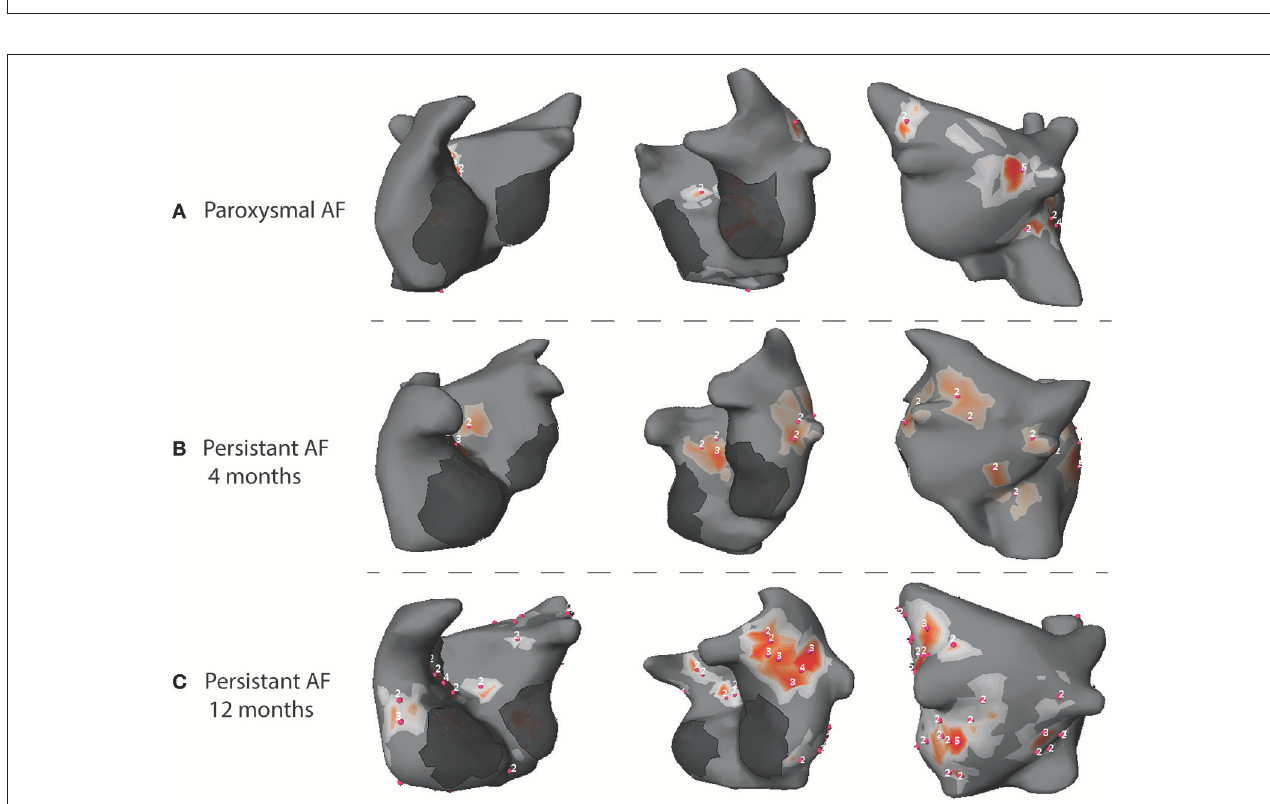
FIGURE 4 | Phase maps acquired during AF in patients with PAF (A) , PsAF of 4 months (B) and long lasting PsAF > 12 months (C) . Red spots identify sites of phase singularity.